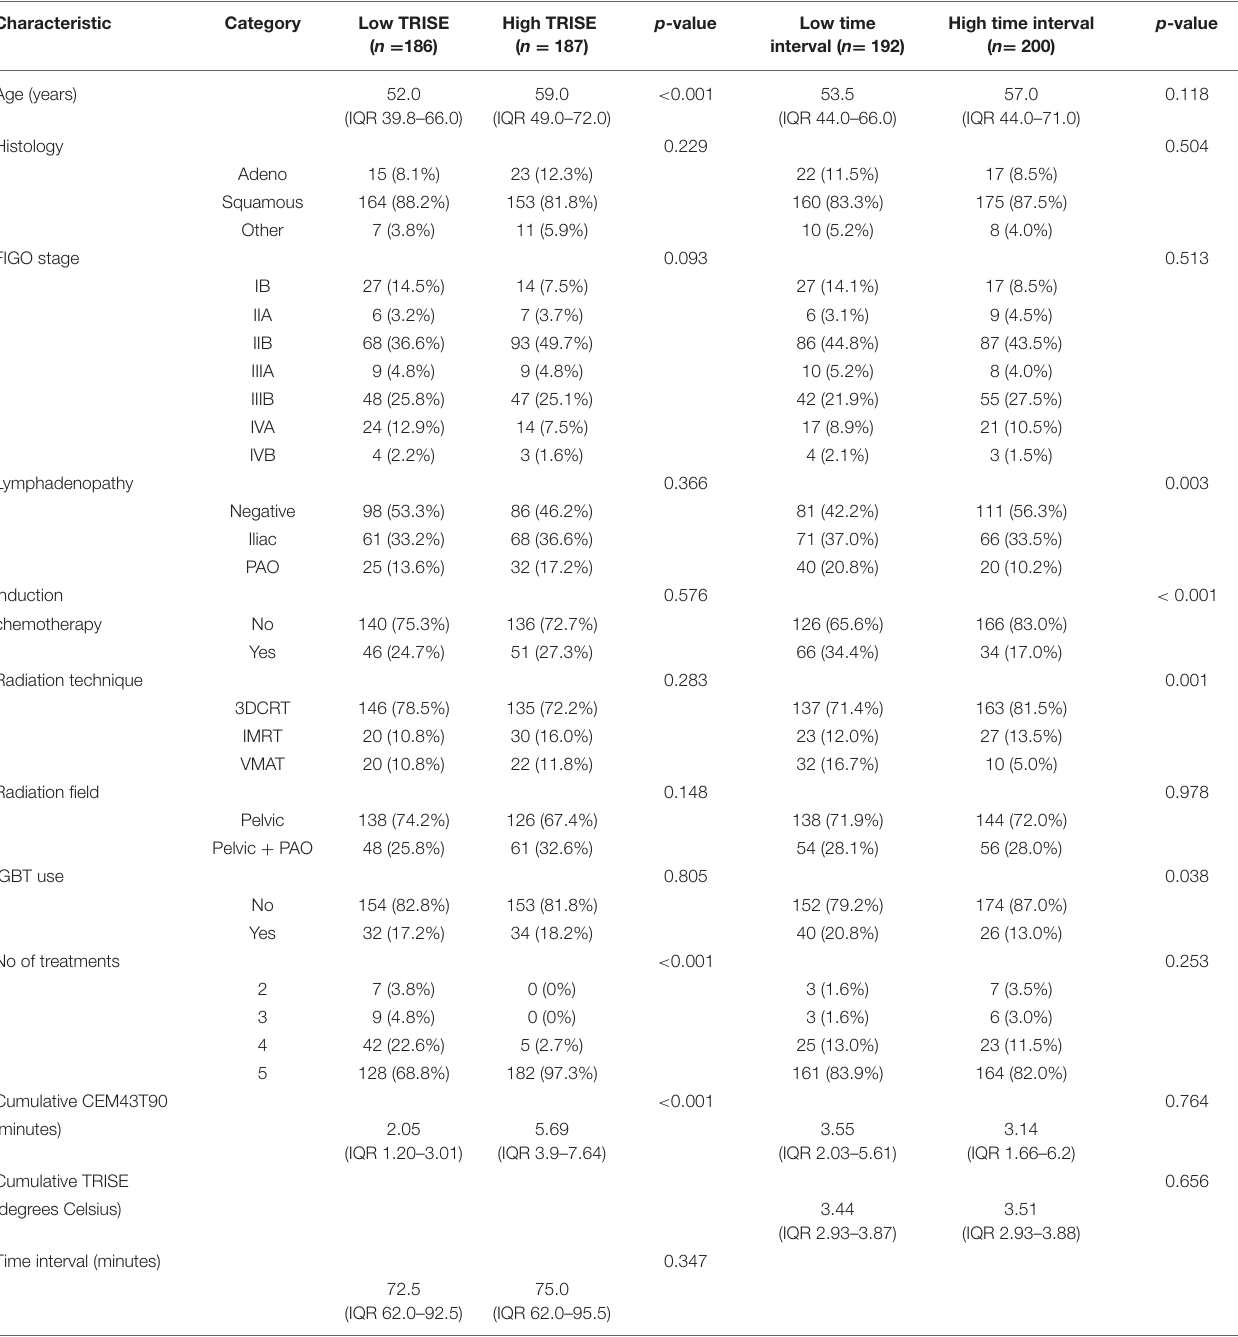
TABLE 2 | Comparison of low and high TRISE and low and high time interval groups.